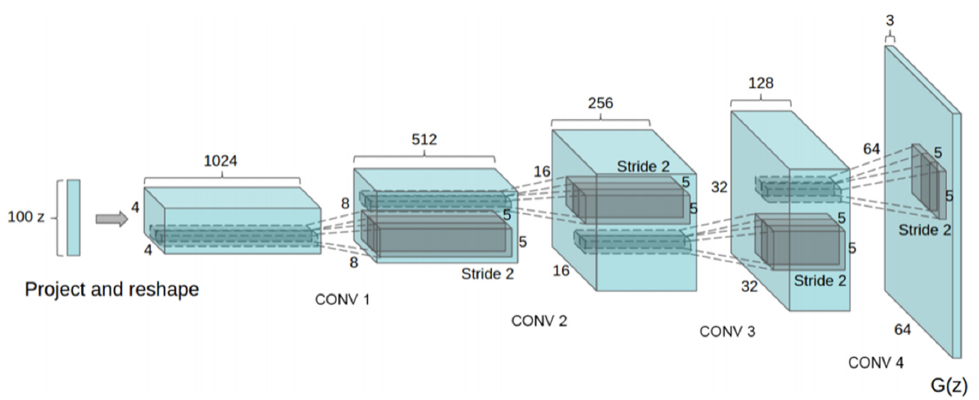
Fig. 3 The network structure of